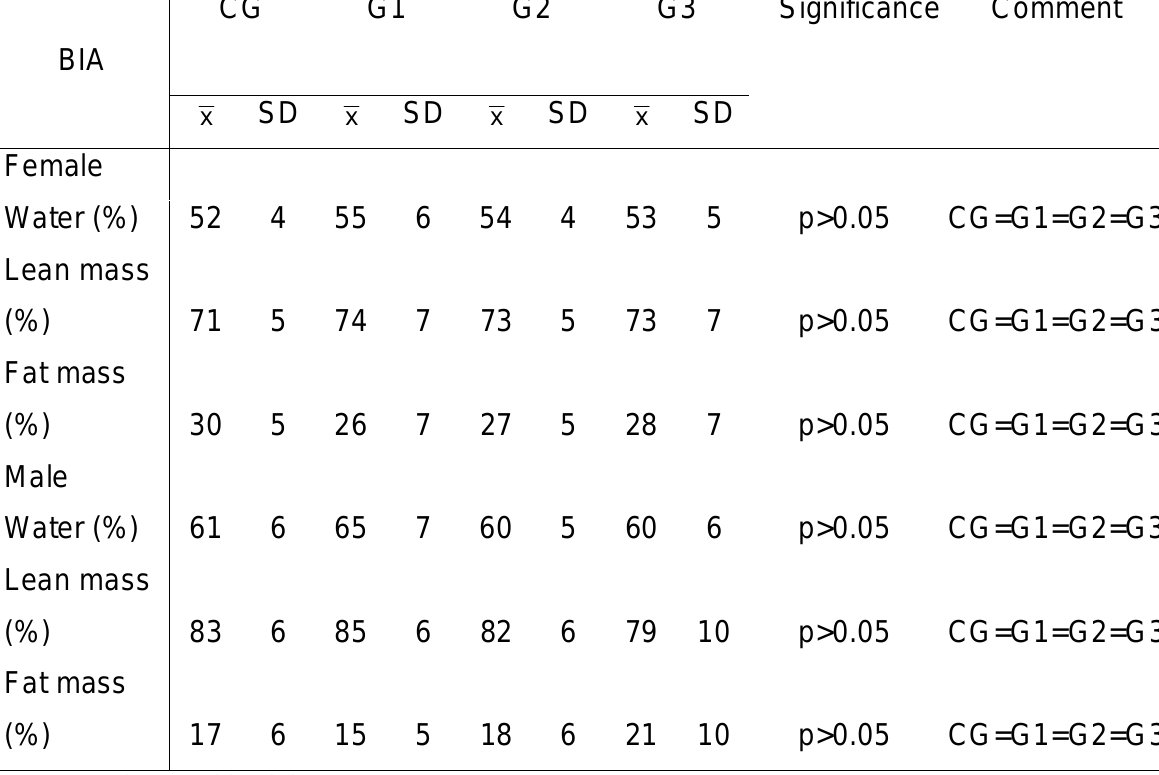
Table 5. Mean ( x ) and standard deviation (SD) of the bioelectrical impedance analysis (BIA) of the 62 subjects, HIV-1 infected or not, according to the study group and